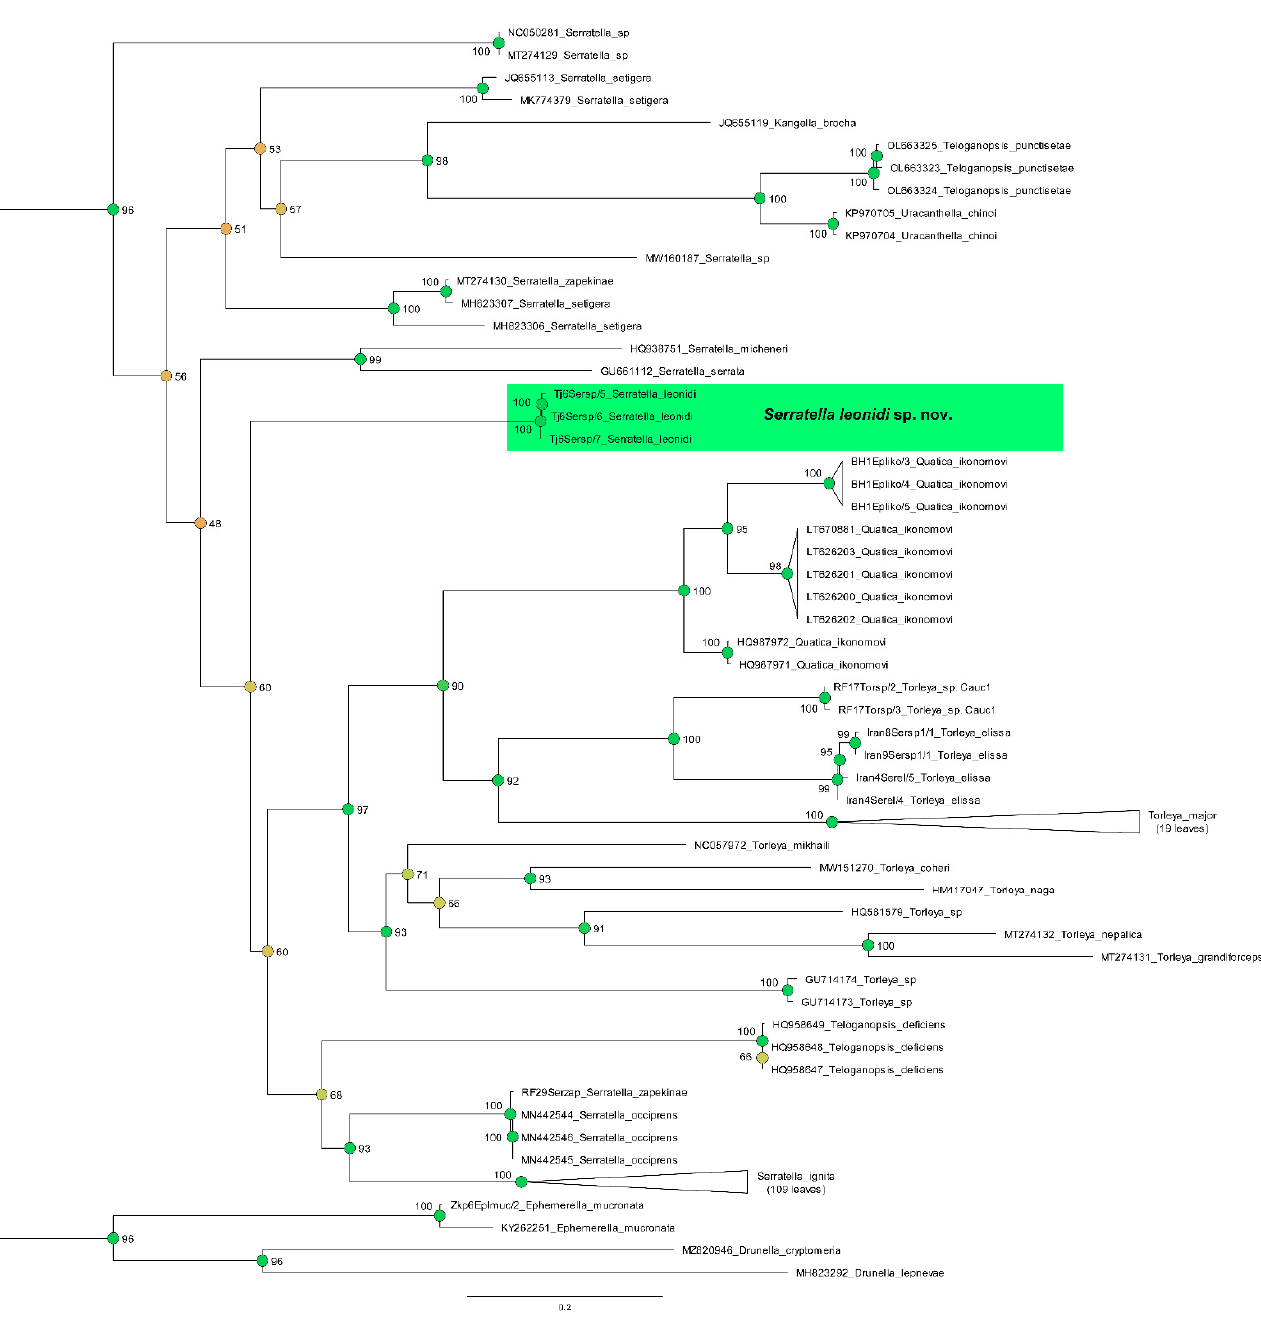
Figure 12. Maximum likelihood tree including representatives of tribe Hyrtanellini. Branches provided with Bootstrap supports (BS). Support values are colored based on confidence at internal nodes; from yellow (low) to green (high). Green background marks new species.